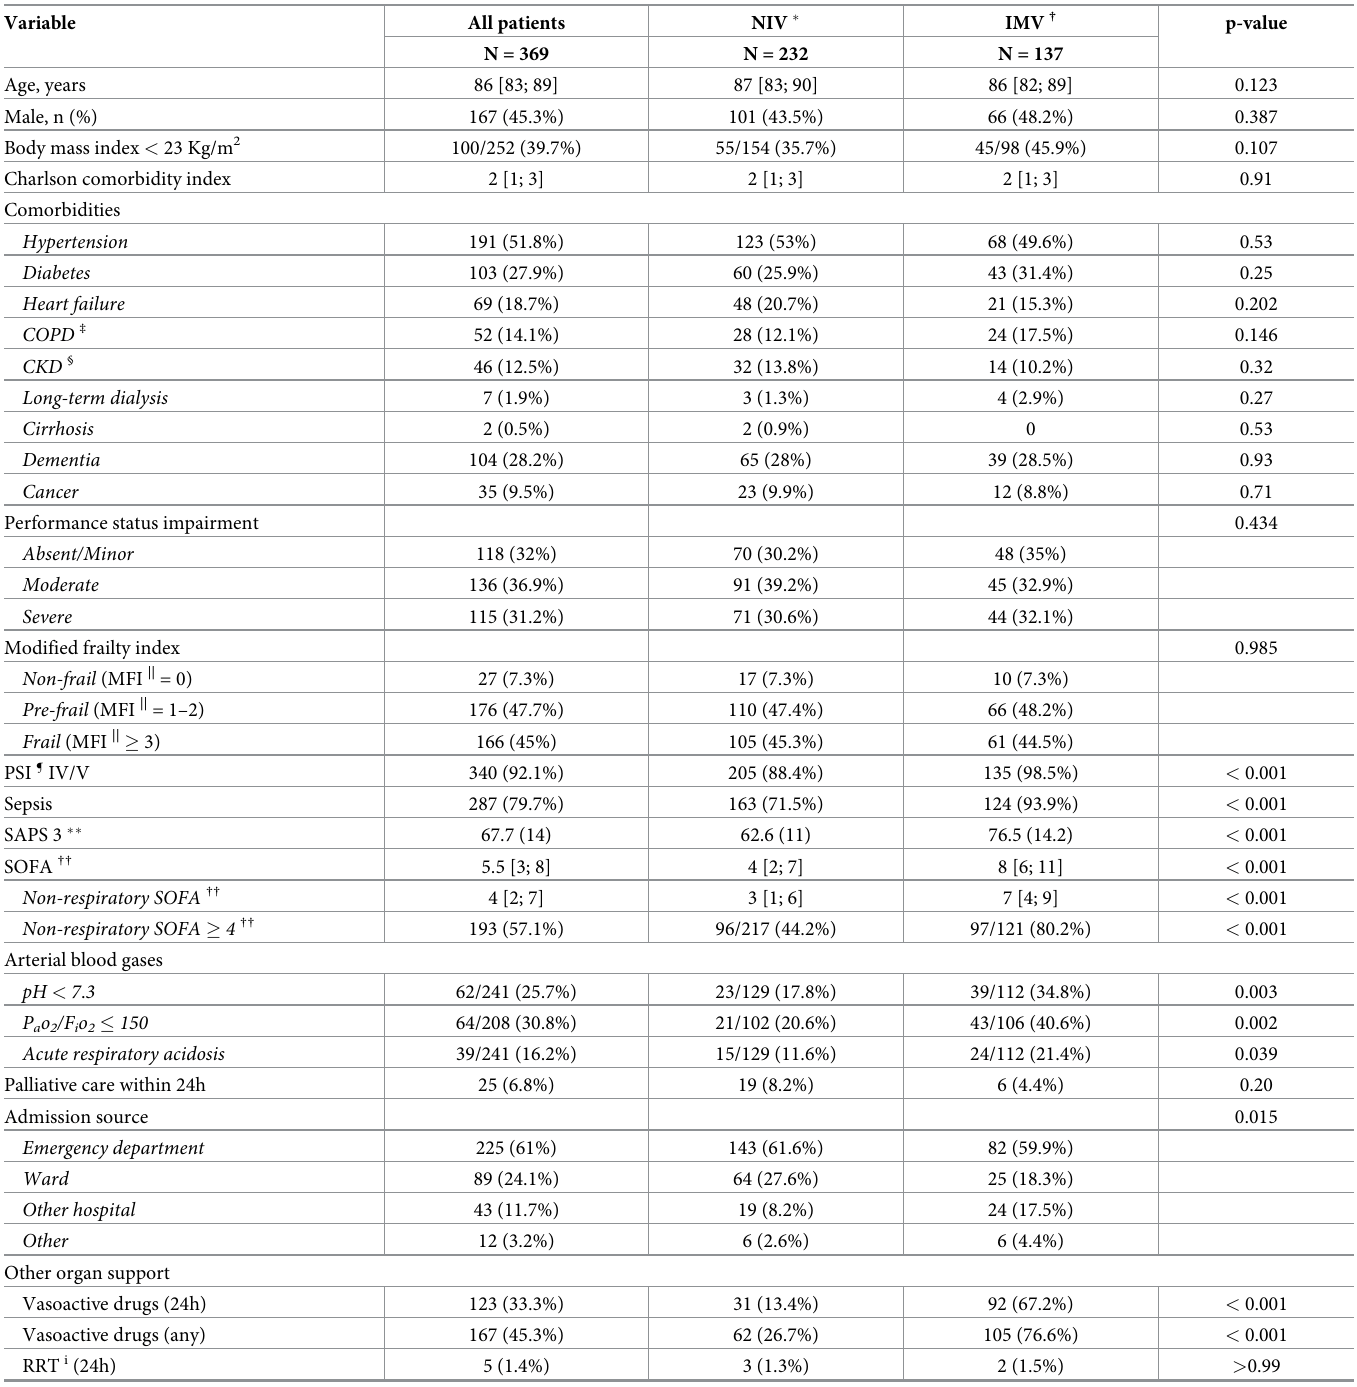
Table 1. Patient characteristics at intensive care unit